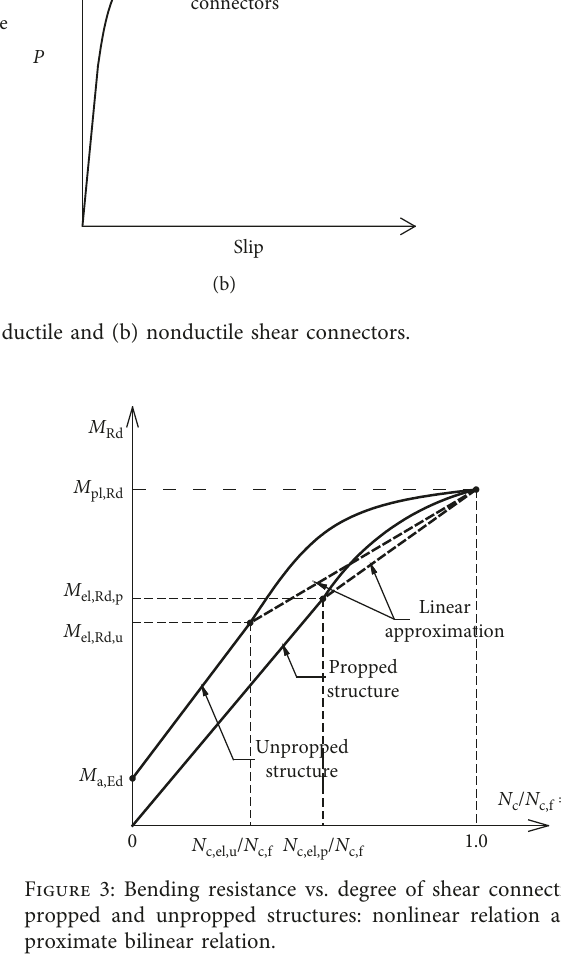
Figure 3: Bending resistance vs. degree of shear connection for propped and unpropped structures: nonlinear relation and ap- proximate bilinear